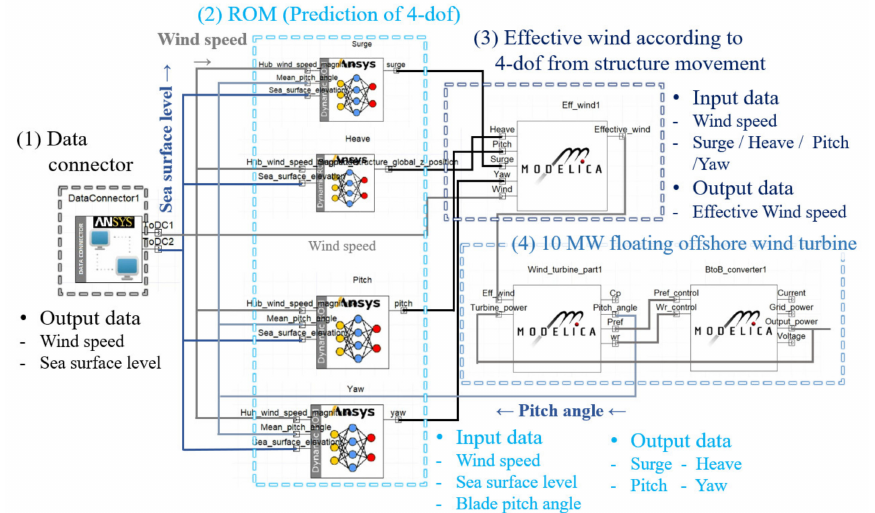
Figure 4. Configuration of the P-bOPM of a 10 MW FOWT